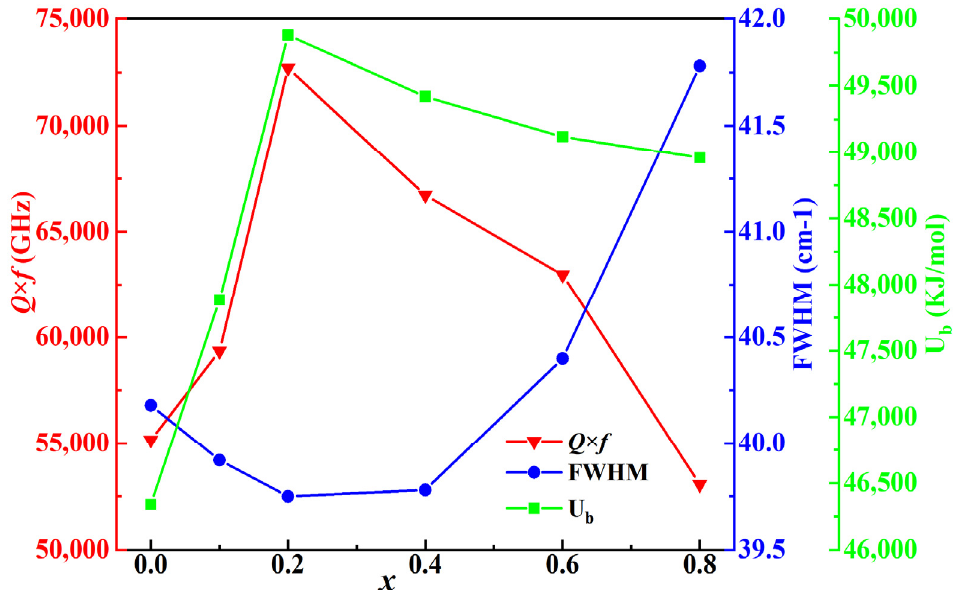
Figure 10. The Q × f value, FWHM and U b of BSZN ceramics.